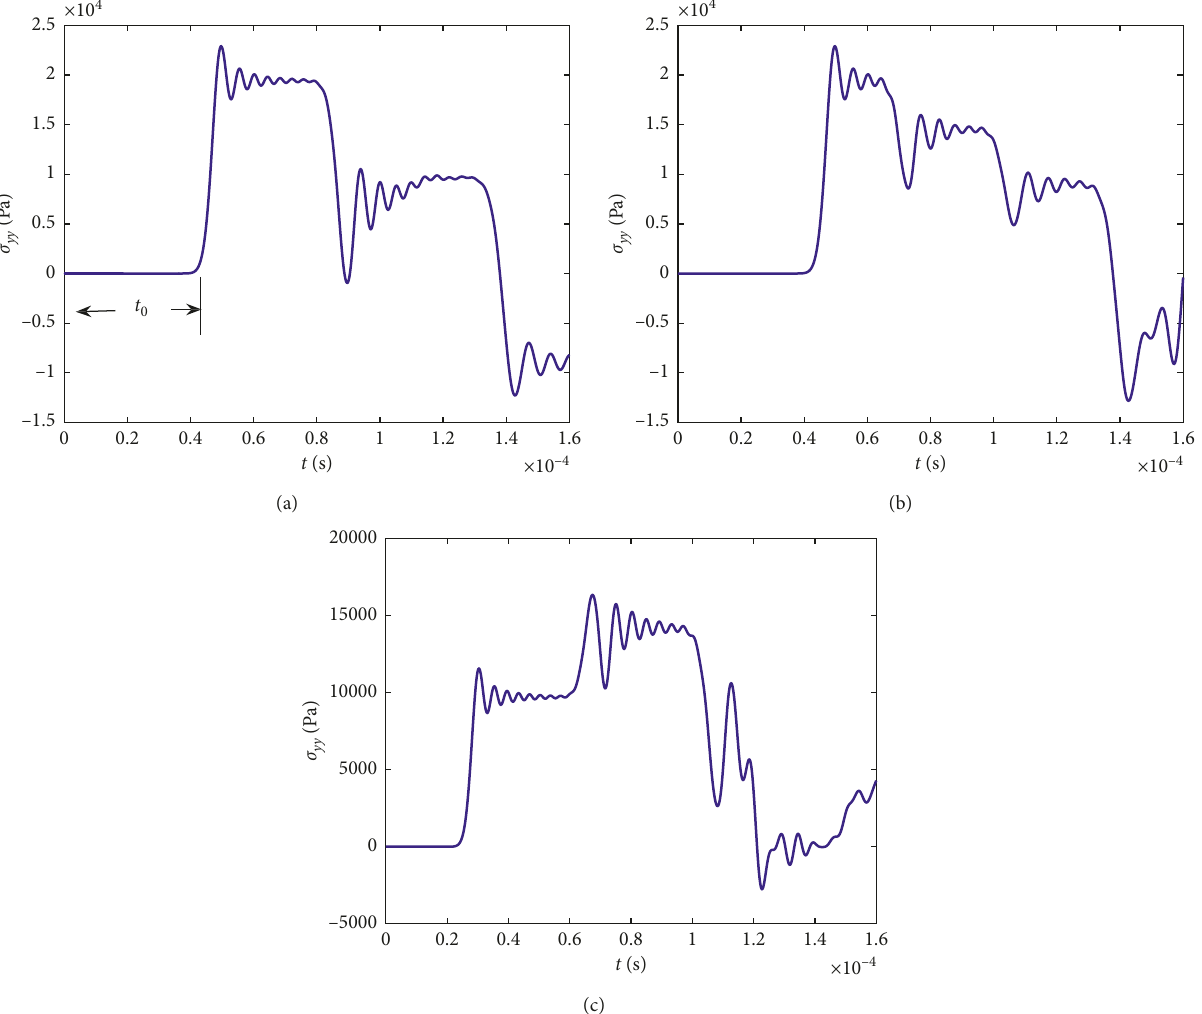
Figure 2: Normal stress of phonon field versus time (a) at the point A A ) towards the right in the horizontal direction; (c) at the point A 2